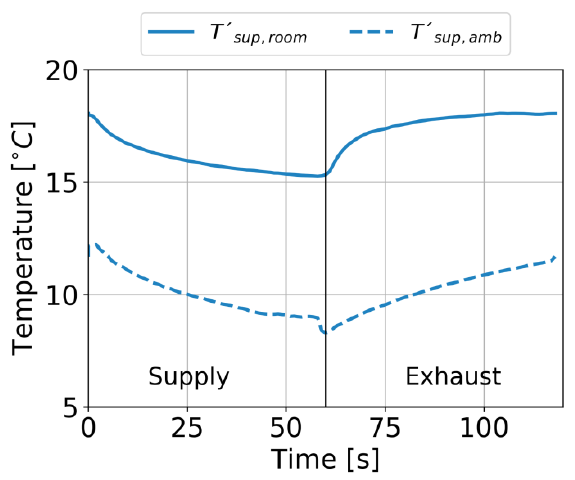
(cid:48) (cid:48) sup,room sup,amb and T